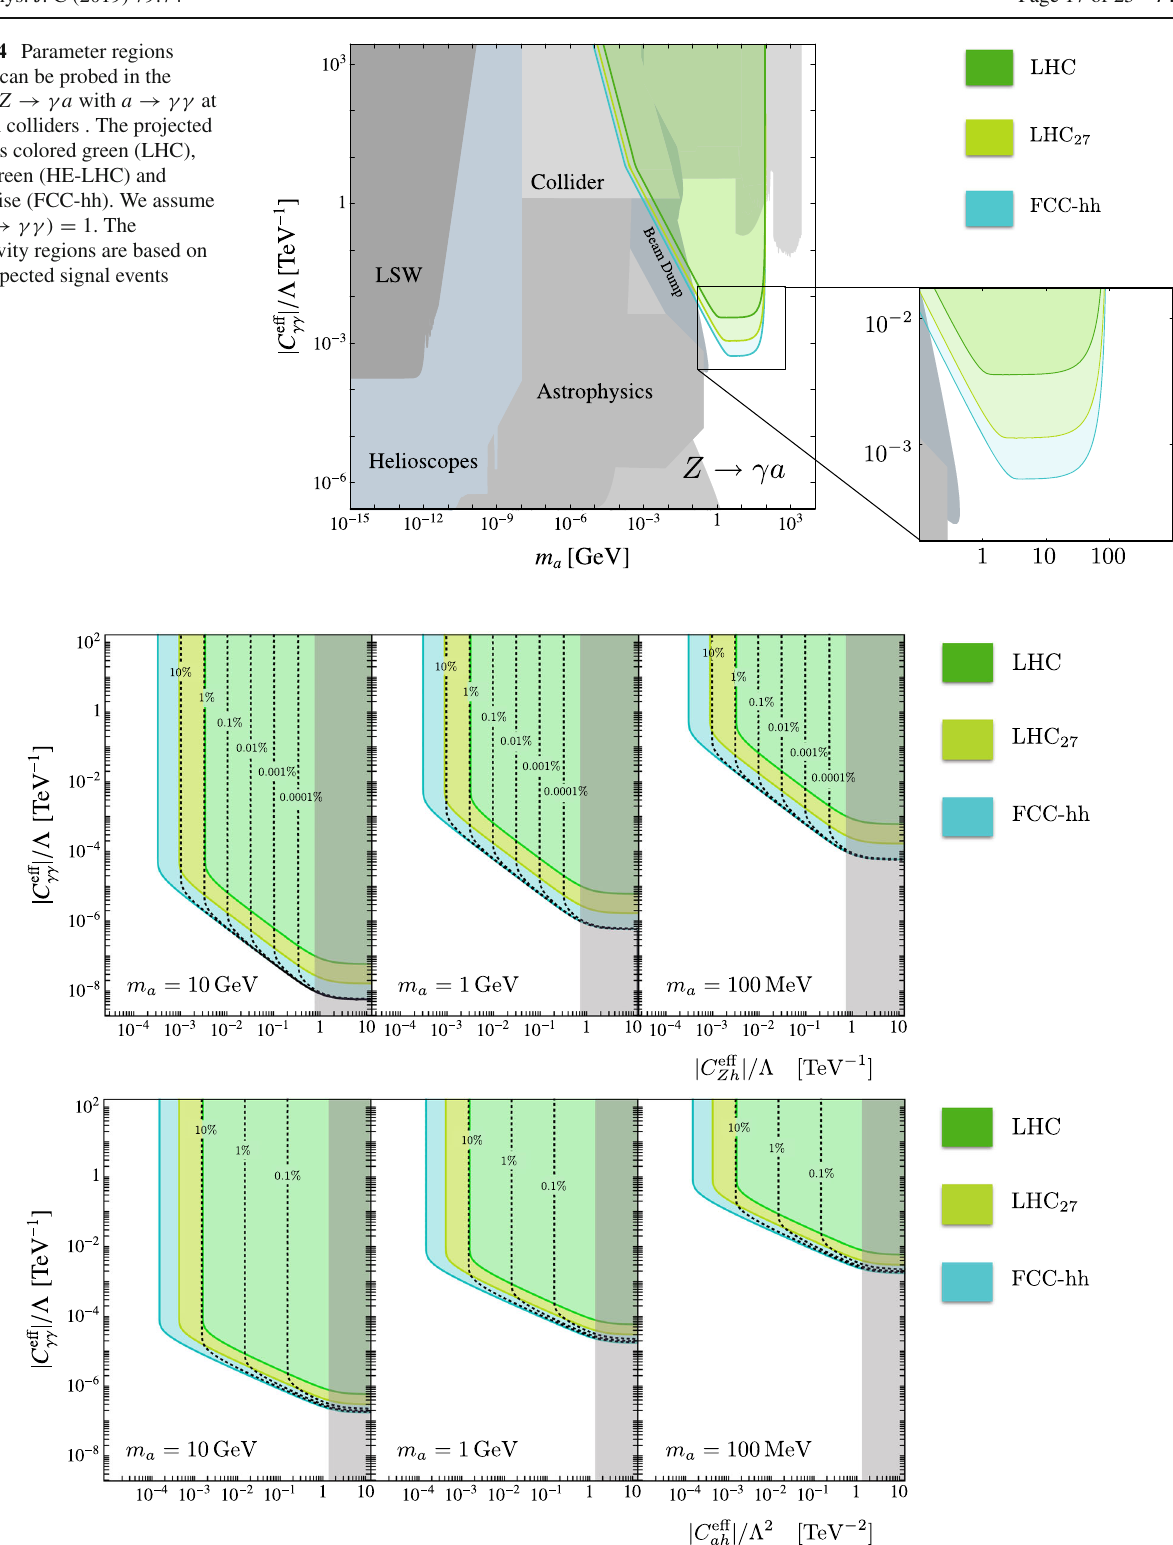
Fig. 15 Projected reach in searches for h → Za → (cid:10) + (cid:10) − + 2 γ and h → aa → 4 γ decays with the LHC (green), HE-LHC (light green) and a 100TeV collider (blue). The parameter region with the solid con-